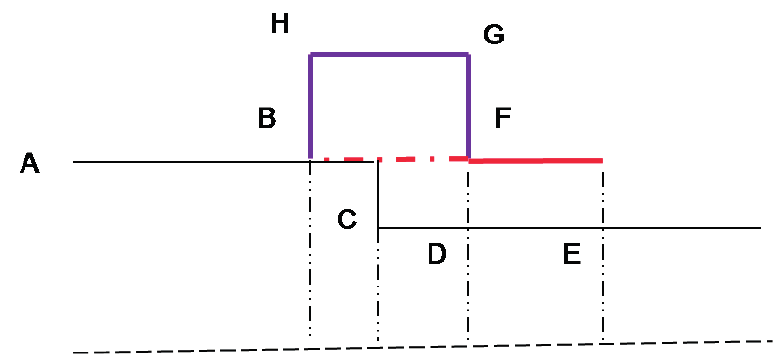
Figure 11. Cross-sections of old and new DSMs, where the black solid line BCDE represents the cross-section of the old DSM and the red and purple lines BHGFI represent the cross-section of the new DSM. The purple line BHGF represents the cross-section of a newly built building. The red line BCFI represents the cross-section of the new terrain.